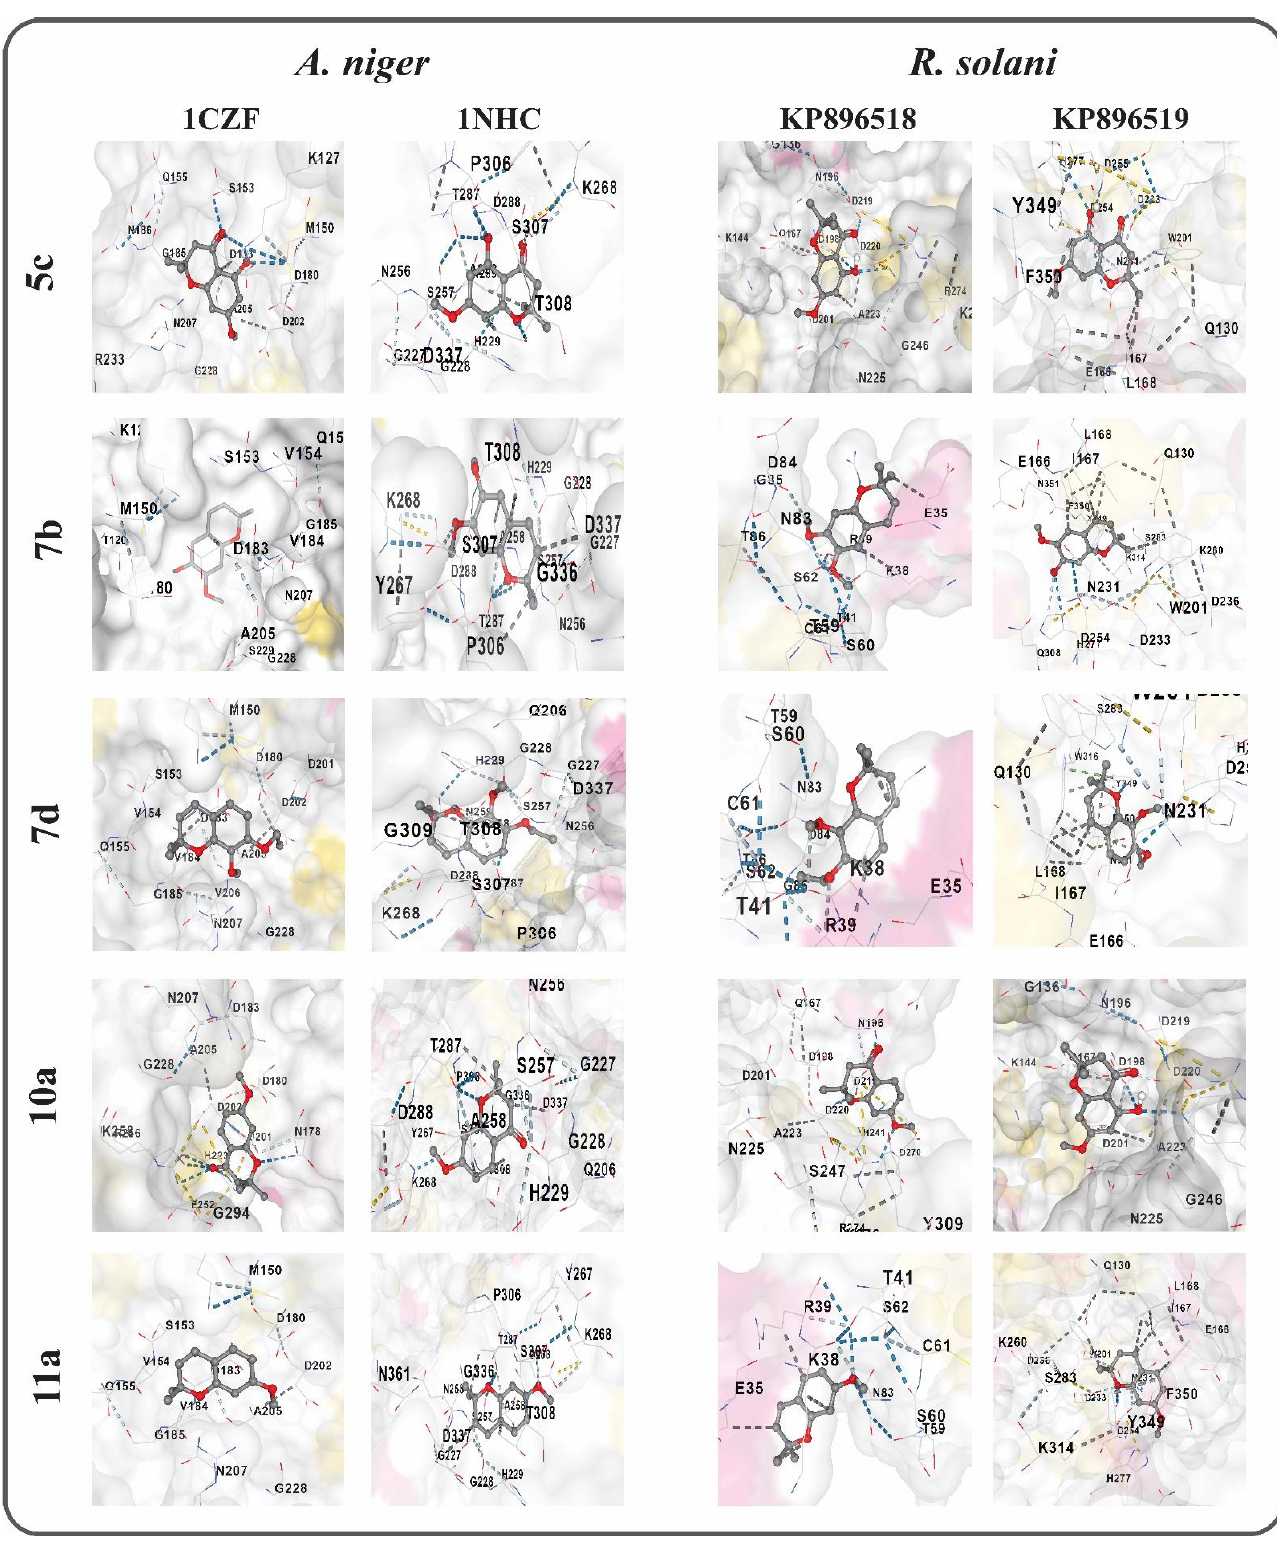
Figure 1. Molecular docking 3D binding models of the tested compounds against polygalactouronases encoded by A. niger (1CZF and 1NHC) and R. solani (KP896518 and KP896519).